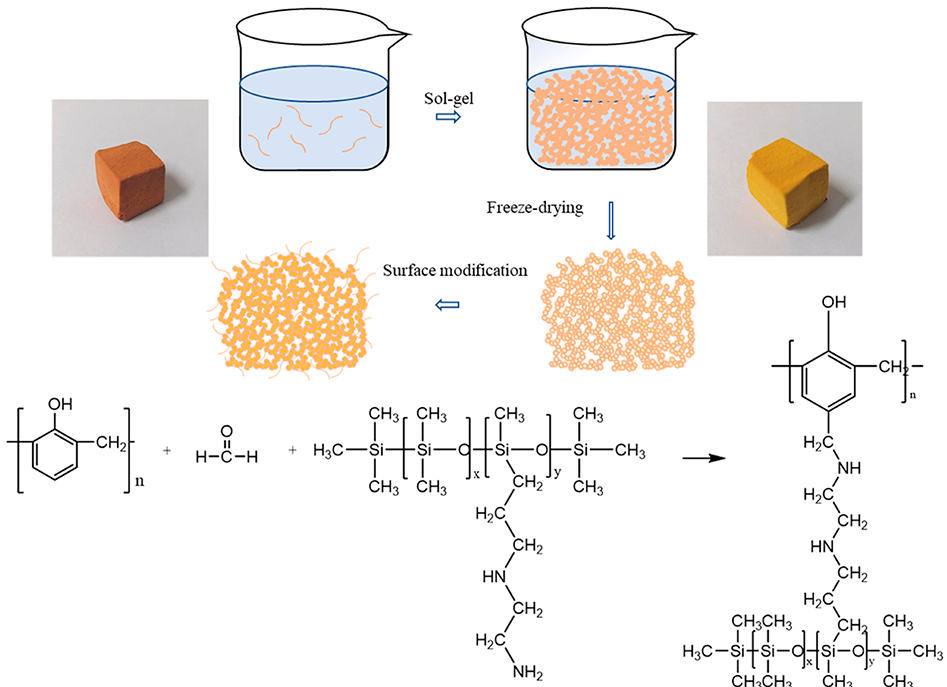
Scheme 1. PF xerogel synthesis schematic diagram and Mannich reaction equation for amino silane modified PF xerogel.